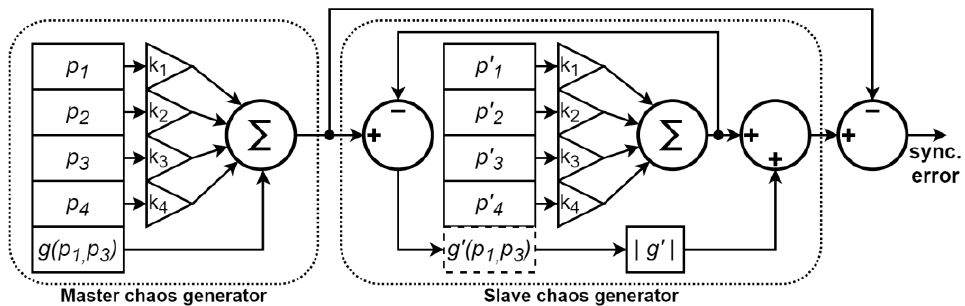
Figure 4. Structure of chaotic synchronization and its error estimation method.